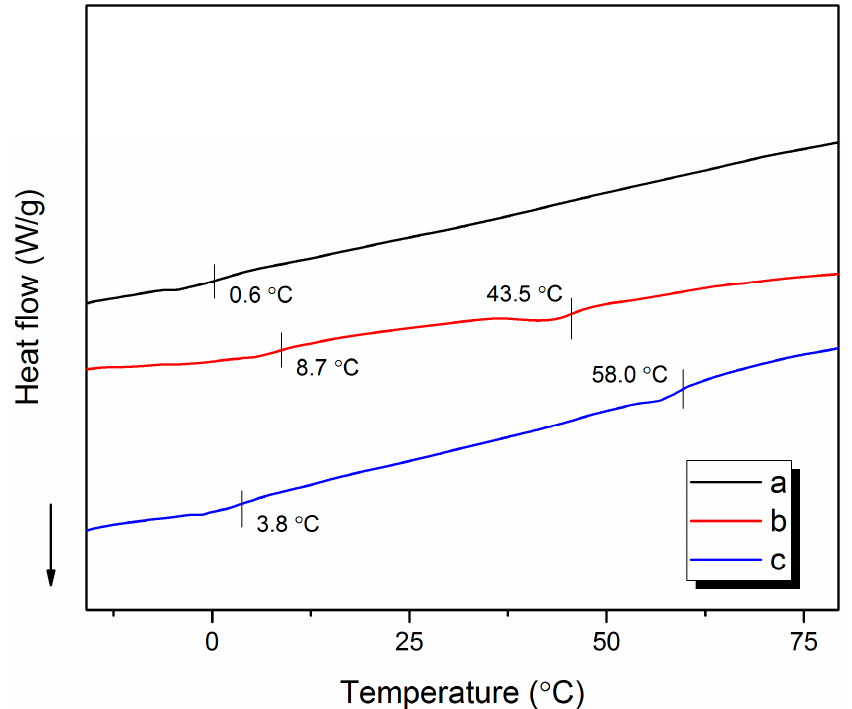
Figure 6. DSC curves for the low gloss acrylic polymer films with crosslinker AMA contents ranging from ( a ) 0 wt % to ( b ) 0.2 wt % and to ( c ) 0.4 wt %, respectively.